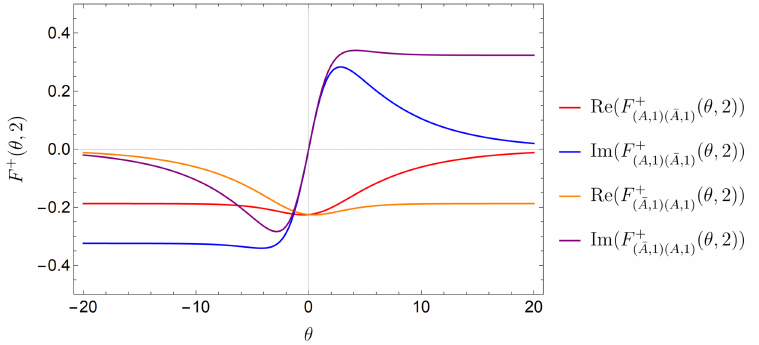
Figure 3 . Two-particle form factors of the composite twist field T + shows the A ¯ A and ¯ AA form factors, which are different, for real values of the rapidity difference θ . They converge to a non-zero constant as θ → ∓∞